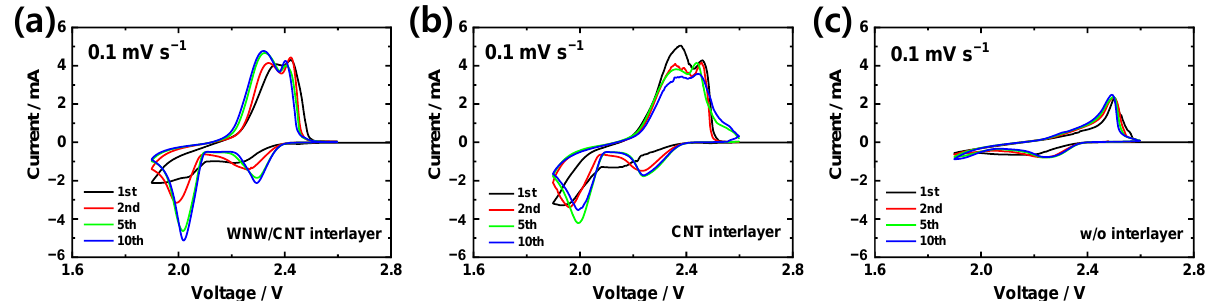
Figure 4. Cyclic voltammetry curves of lithium-sulfur cells with ( a ) WNW/CNT interlayer, ( b ) CNT interlayer, and ( c ) without an interlayer.